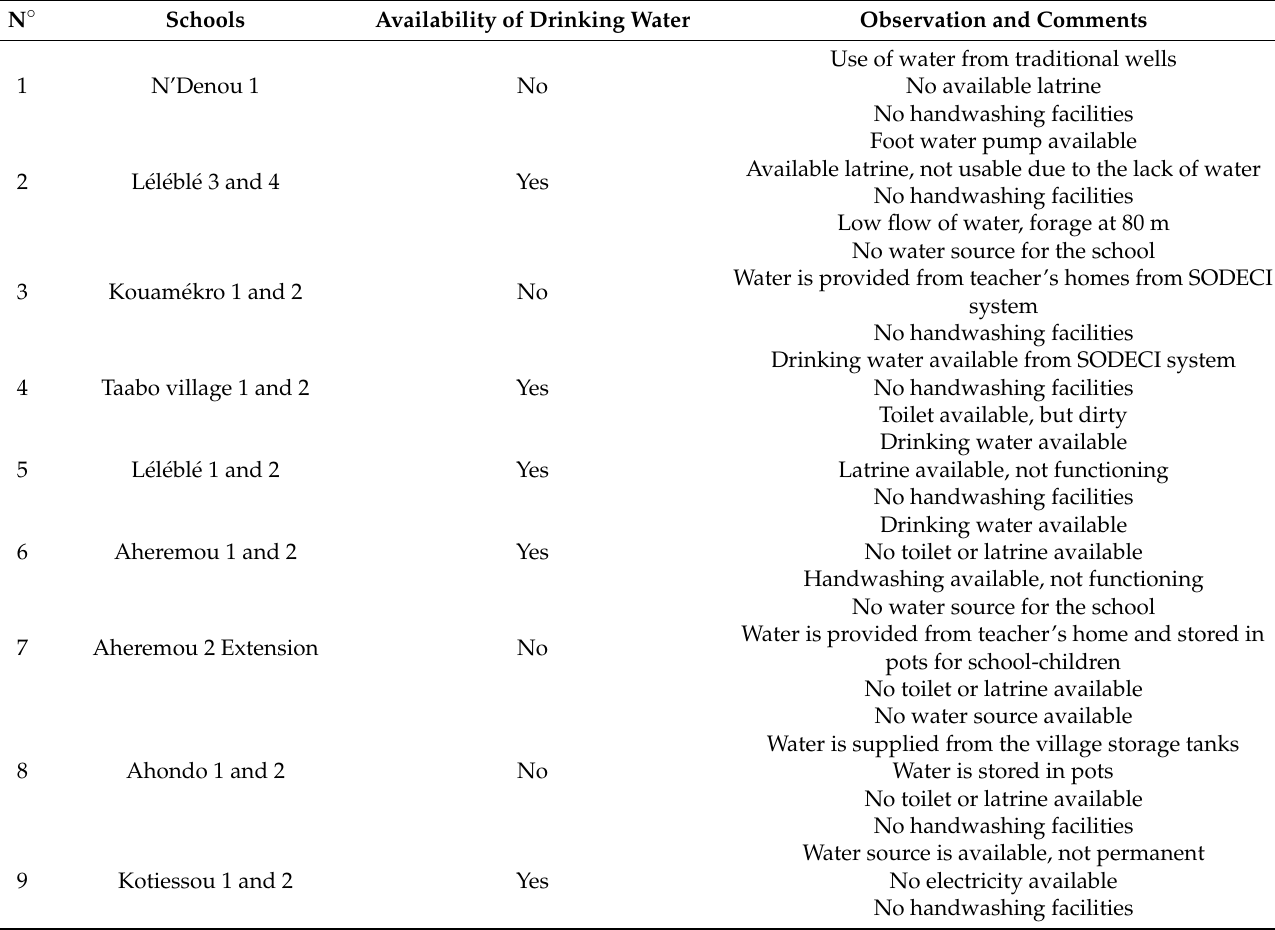
Table A1. Description of schools’ WASH characteristics in the Taabo HDSS (October–November